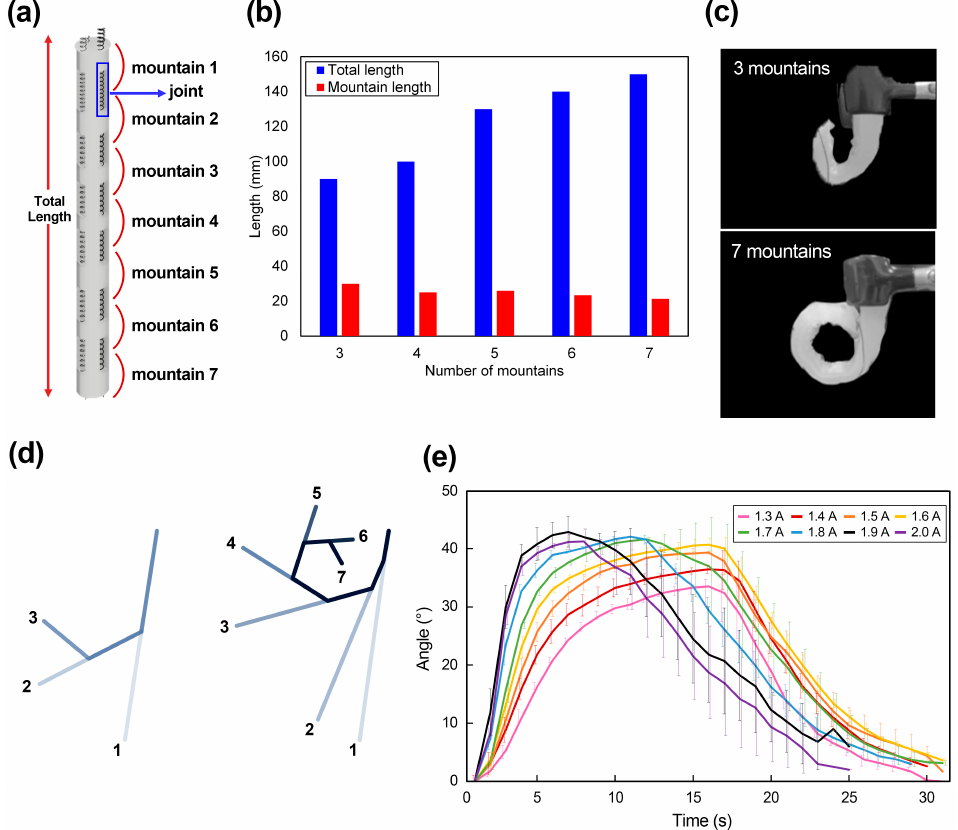
Figure 5. ( a ) Conceptual view of the soft actuator; ( b ) The total length of each actuator according to the number of mountains; ( c ) Images of deformed actuators—these show the shape when there are three and seven mountains; ( d ) Deformation results depending on the number of mountains. The numbers in the figure indicate the number of mountains; and ( e ) Deformation angle with different input currents. In the test, the actuator with seven mountains was the test subject.